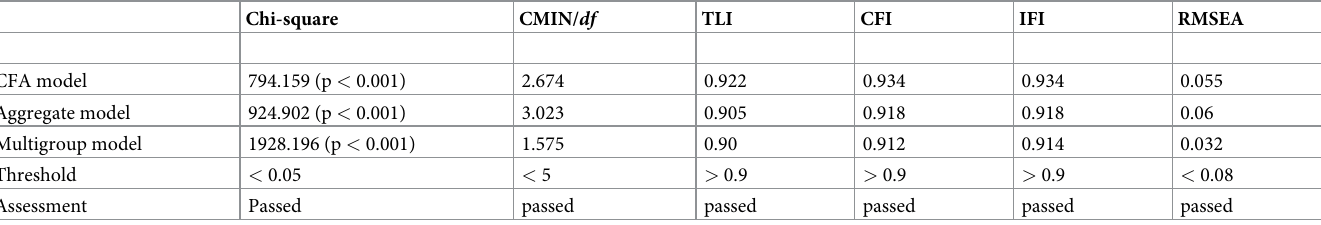
Table 2. Measurement model results.